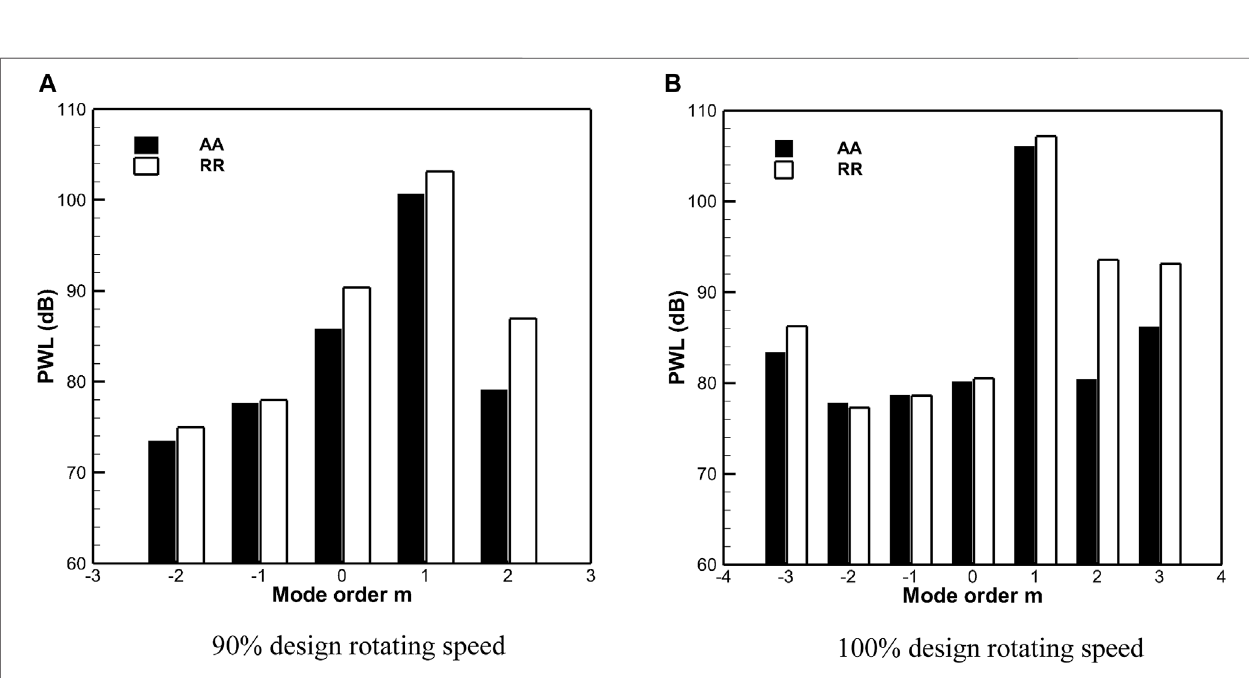
Frontiers in Energy Research |